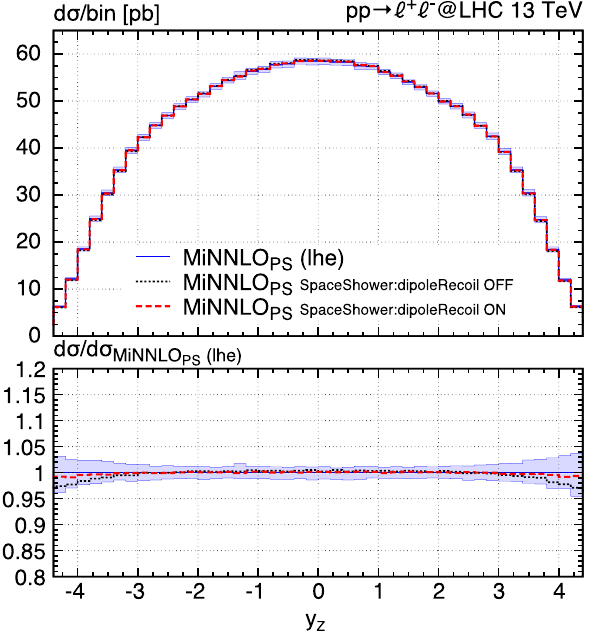
Fig. 2 Rapidity distribution of the Z boson. The plot com- pares MiNNLO PS predictions at LHE level (blue, solid) and after showering using different recoil schemes in Pythia8 with the option SpaceShower:dipoleRecoil 0 (black, dotted) and SpaceShower:dipoleRecoil 1 (red, dashed). The lower panel shows the ratio to the prediction at LHE